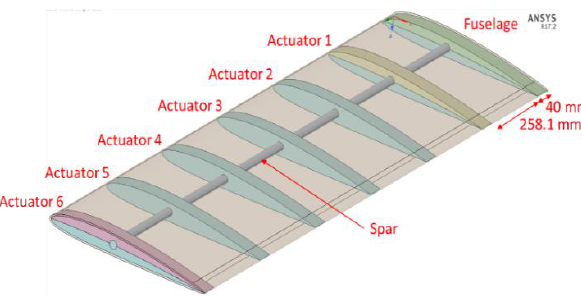
Figure 2. Computational model of camber morphing wing: actuators 1 – 6 show the position of the morphable ribs and the fixed spar location. Table 1. Detail Specifications of RQ-7, Aircraft Model for